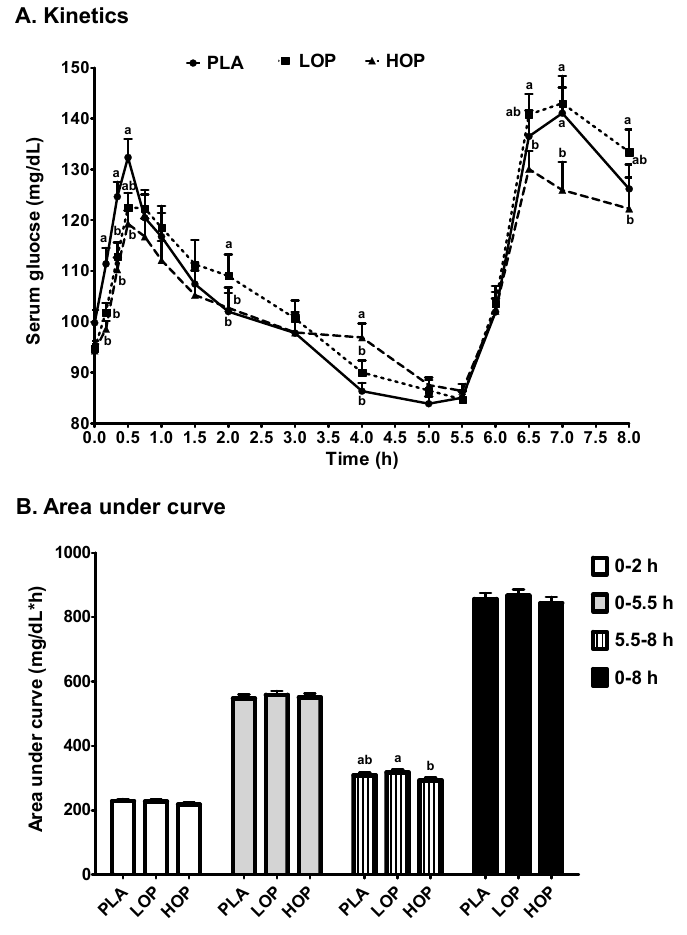
Figure 2. ( A ) Kinetics and ( B ) area under the curve of serum glucose in the subjects consuming one of three study beverages, placebo (PLA), Low orange pomace (LOP), and High orange pomace (HOP), along with a high fat and carbohydrate breakfast and a high fat and carbohydrate lunch after the 5.5-h blood draw. Serum glucose was measured at 0, 10, 20, 30, and 45 min and 1, 1.5, 2, 3, 4, 5, 5.5, 6, 6.5, 7, and 8 h. The area under the curve of serum glucose was calculated in four time periods; 0–2 h, 0–5.5 h, 5.5–8 h, and 0–8 h. a,b Means at the same time point without sharing the same letter differ, tested by the general linear mixed effects model followed by the Tukey HSD multi ‐ comparison test, p ≤ 0.05. Serum insulin values at the baseline did not differ between the three study beverages (Figure 3A). OP decreased the post ‐ breakfast insulin C max 1 by ≥ 10%. LOP delayed the T max 1 by 14 min